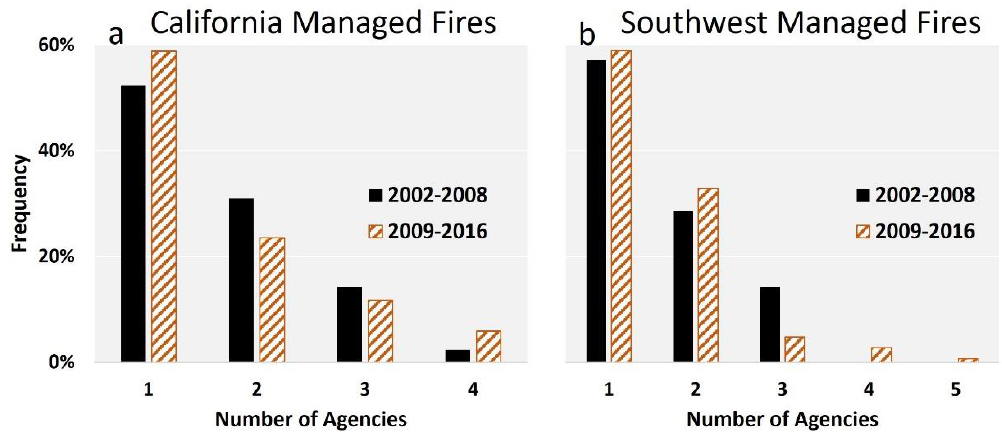
Figure 4. Comparison of managed wildfires in California before (2002–2008) and after (2009–2016) the 2009 policy guidance based on ( a ) distance to wilderness, ( b ) distance to WUI, and ( c ) the percentage of high-severity burn area. The geographic characteristics of managed wildfires in California did not differ between before and after the implementation of the 2009 policy guidance.